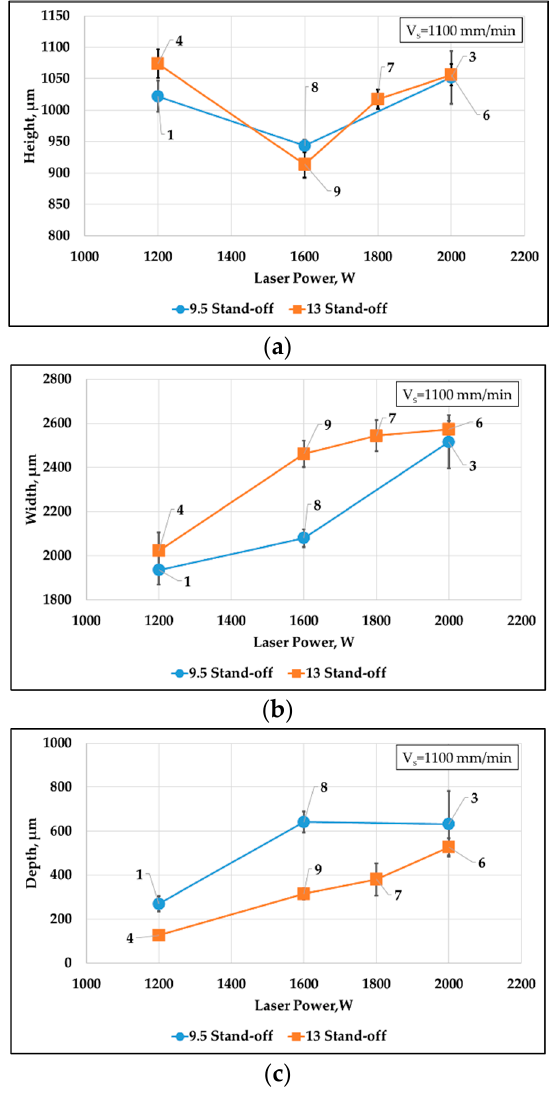
Figure 4. Influence of laser power of 1200, 1600, 1800 and 2000 W on ( a ) height; ( b ) width; and ( c ) depth of deposits at laser stand-off distances of 9.5 mm and 13 mm at a constant scanning speed of 1100 mm/min.